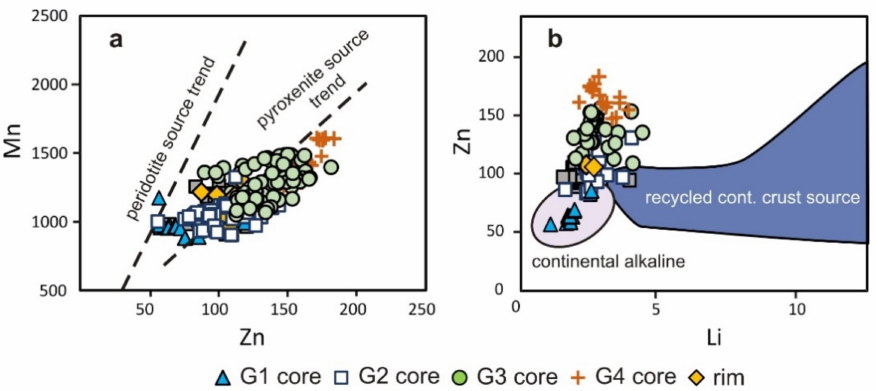
Figure 12. Mn vs. Zn ( a ) and Zn vs. Li ( b ) (ppm) for olivine macrocrysts from the Terina complex. Pyroxenite and peridotite trends are from [78]. Composition fields of recycled continental crust source and continental alkaline rocks are from [46]. Legend as in Figure